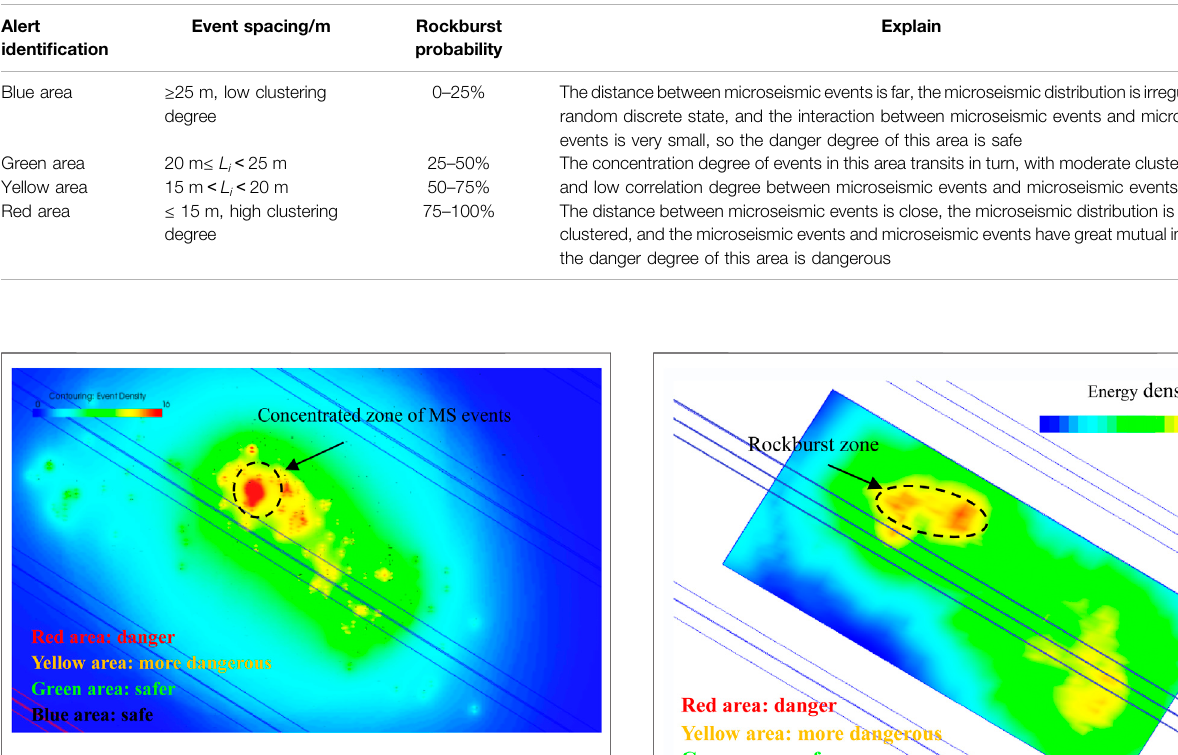
TABLE 3 | Safety grade table of microseismic event density.